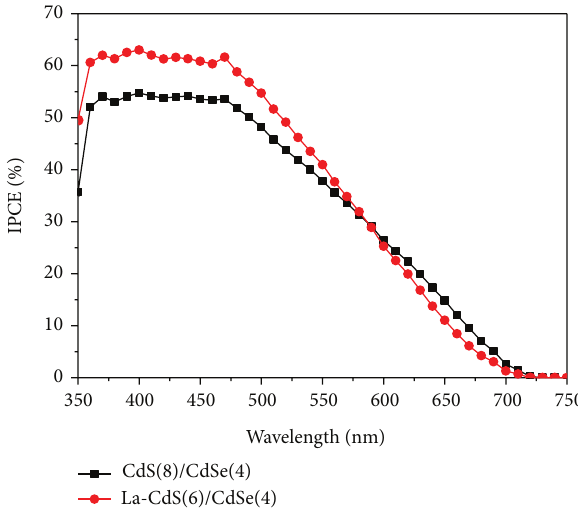
Figure 9: The ultraviolet photoelectron spectroscopy around doped CdS.